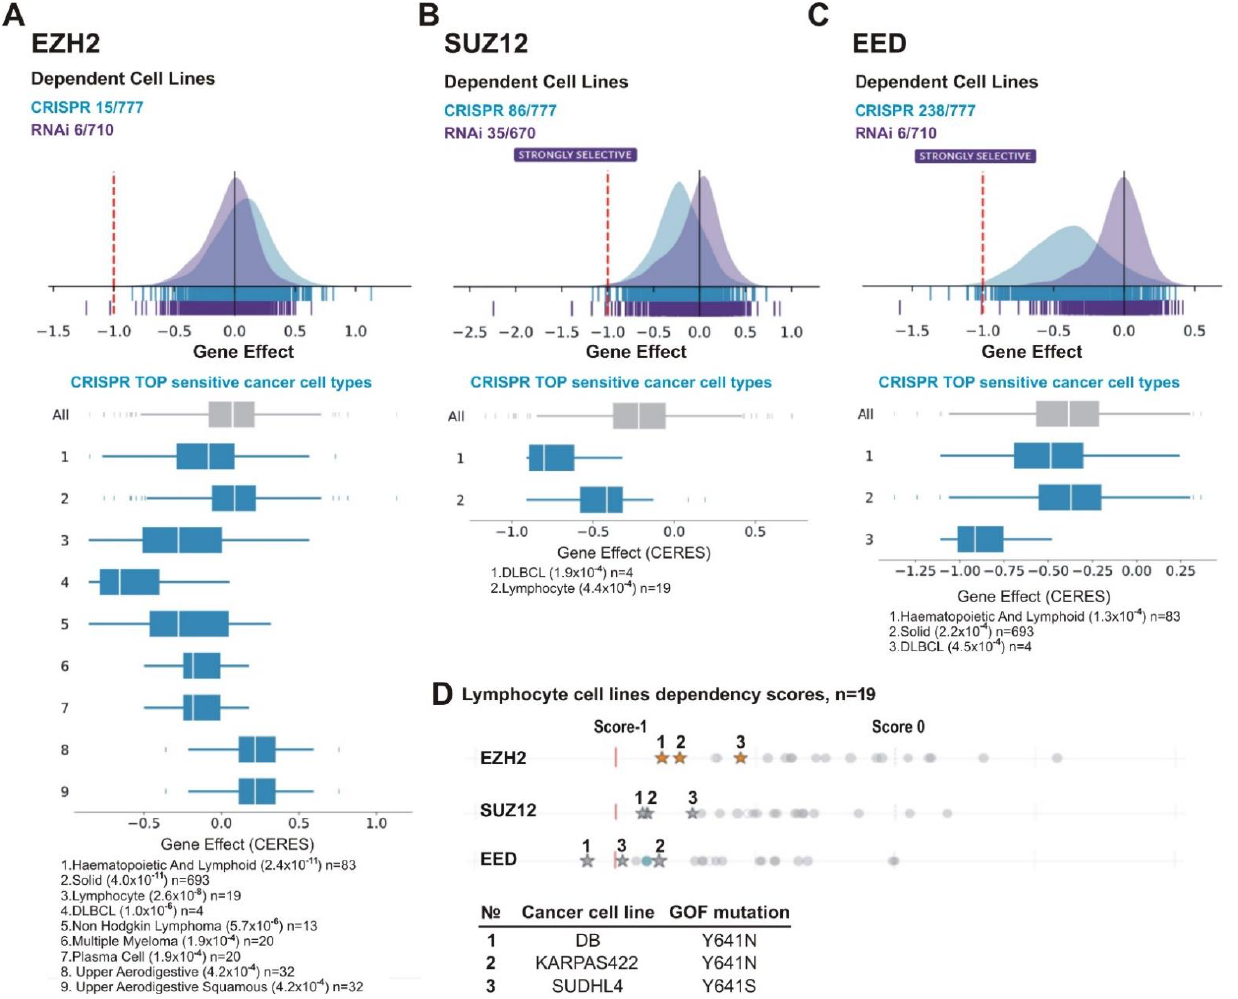
Figure 7. Lymphoid cancer cell lines are particularly sensitive to PRC2 knockout. The analysis was performed using DepMap database. ( A ) EZH2 , ( B ) SUZ12 and ( C ) EED . ( A – C ) UP: schematic representation of the effects of gene knockout (by CRISPR, blue) or knockdown (by RNAi, purple) on cells growth and viability. X-axis: dependency scores (Gene Effect) reflect the dependence of cell growth and survival upon depletion of a particular gene. Negative values indicate that cell proliferation is decreasing upon the gene depletion and score less than − 0.5 indicates that the gene is required for survival of a given cancer cell line. Numbers next to “CRISPR” and “RNAi” indicate the amount of sensitive cell lines with score < − 0.5/total number of cell lines in each case. DOWN: The TOP sensitive cancer cell types to knockout of EZH2 ( A ), SUZ12 ( B ), and EED ( C ) by CRISPR are shown. ( D ) Lymphoma lines carrying EZH2 GOF mutations are in TOP of cell lines sensitive to EZH2 , SUZ12 or EED knockout. UP: The dependency scores for a panel of lymphoma lines upon knockout of PRC2 genes by CRISPR. Asterisks indicate the cell lines with GOF mutations in the EZH2 SET domain, grey circles—lines without GOF mutations. DOWN: The GOF mutations in test cell lines are